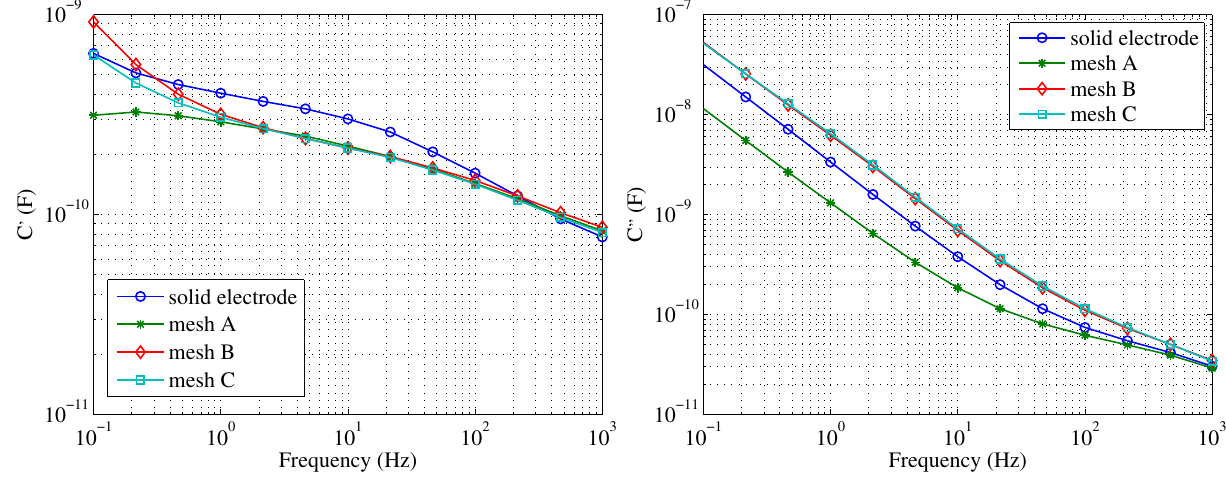
Figure 3. Capacitance (C’) and dielectric loss (C”) measured with different